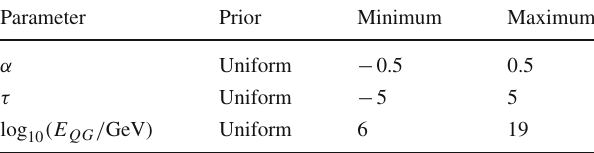
Table 1 Priors used for the calculation of Bayesian evidence for all the three models considered hitherto